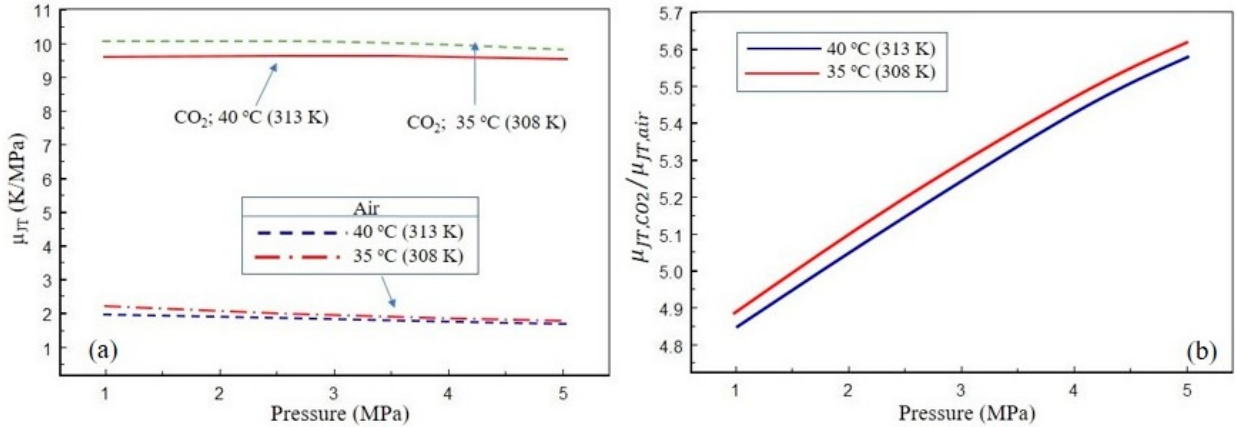
Figure 4. The Joule–Thomson coefficient of gaseous CO 2 and air as a function of the temperature and pressure before expansion, (( a ): Joule-Thomson coefficient of CO 2 and air; ( b ): Ratio of the CO 2 Joule-Thomson coefficient to the air Joule-Thomson coefficient).